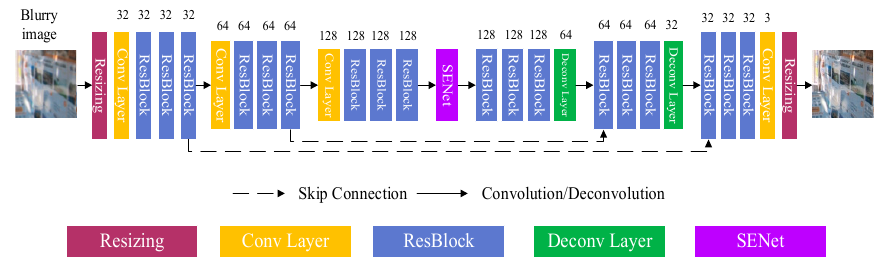
Figure 2. The architecture of the bottom–top–bottom attention network.